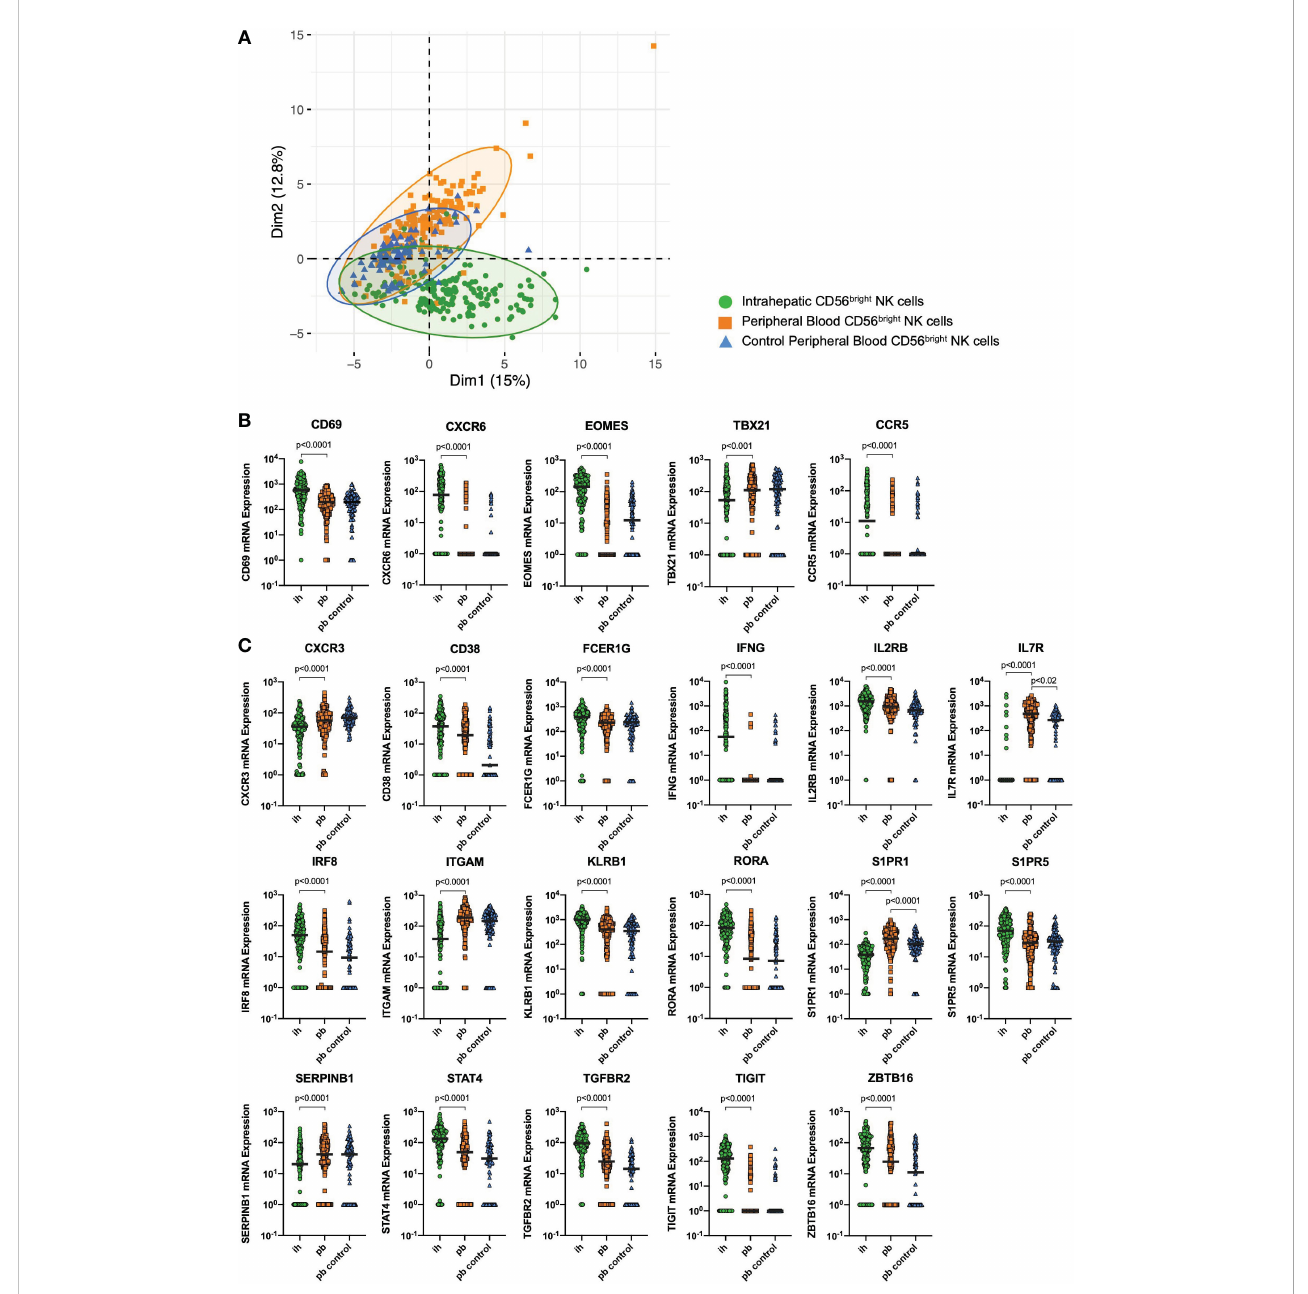
FIGURE 1 Single-cell mRNA expression. (A) Principal component analysis showing clustering of CD56 bright peripheral blood (pb)NK cells from healthy control individuals (blue triangles), CD56 bright pbNK cells from liver resection patients (orange squares) and CD56 bright intrahepatic (ih)NK cells from liver resection patients (green dots). (B) Quantitative analysis of CD56 bright ihNK cells and matched CD56 bright pbNK cells from liver resection patients (n=4), and CD56 bright pbNK cells from healthy control individuals (n=2) showing single-cell mRNA expression of liver-residency markers CD69, CXCR6, CCR5, Eomes and T-bet ( TBX21 ). (C) Quantitative analysis of CD56 bright ihNK cells and matched CD56 bright pbNK cells from liver resection patients (n=4), and CD56 bright pbNK cells from healthy control individuals (n=2) showing single-cell mRNA expression of selected genes with highly signi fi cant differential gene expression comparing ih and pbNK cells. Green dots representing 178 ihNK cells, orange squares representing 173 pbNK cells and blue triangles representing 89 healthy control pbNK cells. A mixed-effects model with random intercept, considering intra-sample correlations, was used to compare the single-cell mRNA expression data from different donors (or groups). Black line indicates